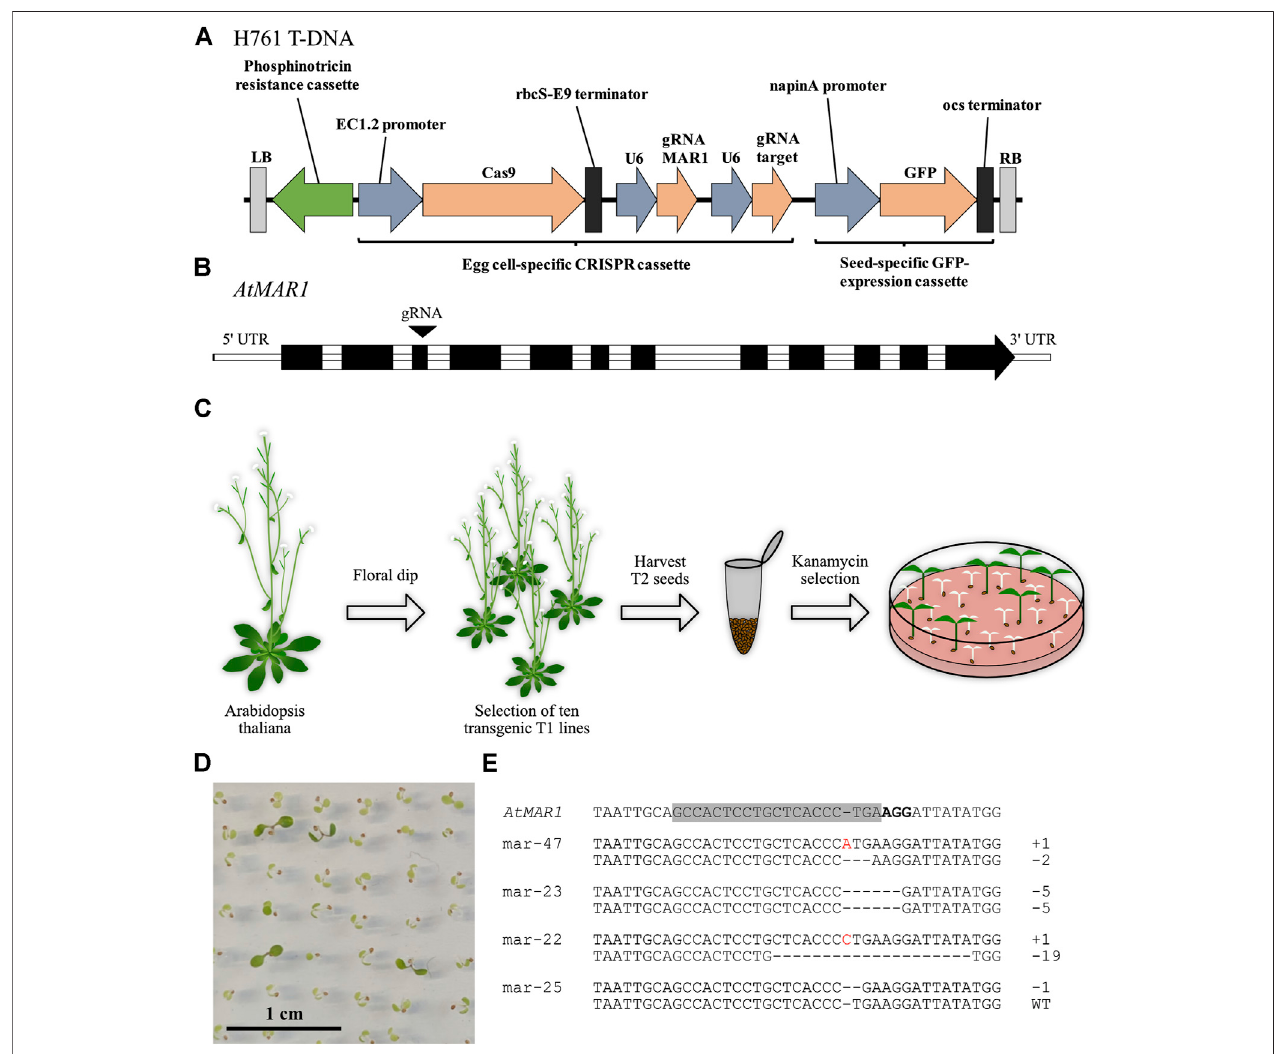
FIGURE 1 | Mutations in MAR1 induced by the CRISPR system confer kanamycin resistance to Arabidopsis thaliana seedlings. (A) T-DNA of H761 that was transferred by fl oral dip. LB/RB: left border/right border, EC1.2: egg-cell speci fi c 1.2, rbcS-E9: ribulose-1,5-bisphosphate carboxylase E9, U6: ubiquitin 6, GFP: green fl uorescent protein, ocs: octopine synthase. (B) Intron-exon structure of the locus At5g26820. The gRNA target site in the third exon is indicated with an arrow. (C) Schematic illustration of the transformation procedure. (D) T2 seedlings of plants transformed with H761 selected for 14 days on ½ MS medium containing 50 mg L − 1 kanamycin. (E) Examplesofmutationsdetectedinkanamycininsensitiveseedlings.TheareaaroundthegRNAtargetsitein MAR1 isdisplayedwiththetarget site highlighted in grey and the PAM in bold letters. Deleted nucleotides are indicated by dashes, inserted nucleotides are displayed in red.